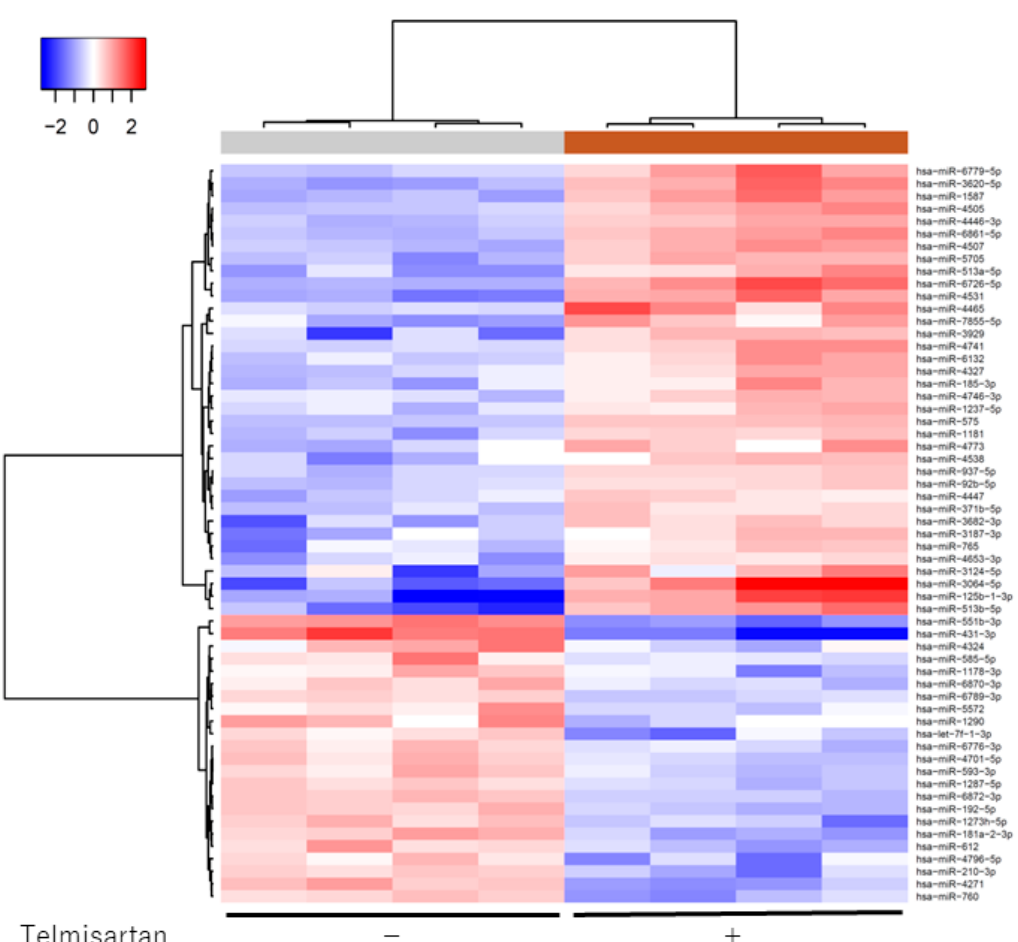
Figure 7. Hierarchical clustering of KYSE180 cells treated with or without telmisartan. KYSE180 cells were clustered according to expression profiles of 60 miRNAs differentially expressed by KYSE180 cells, with or without telmisartan. Top: miRNA clustering color scale indicates relative miRNA expression levels; red: high expression, blue: low expression.